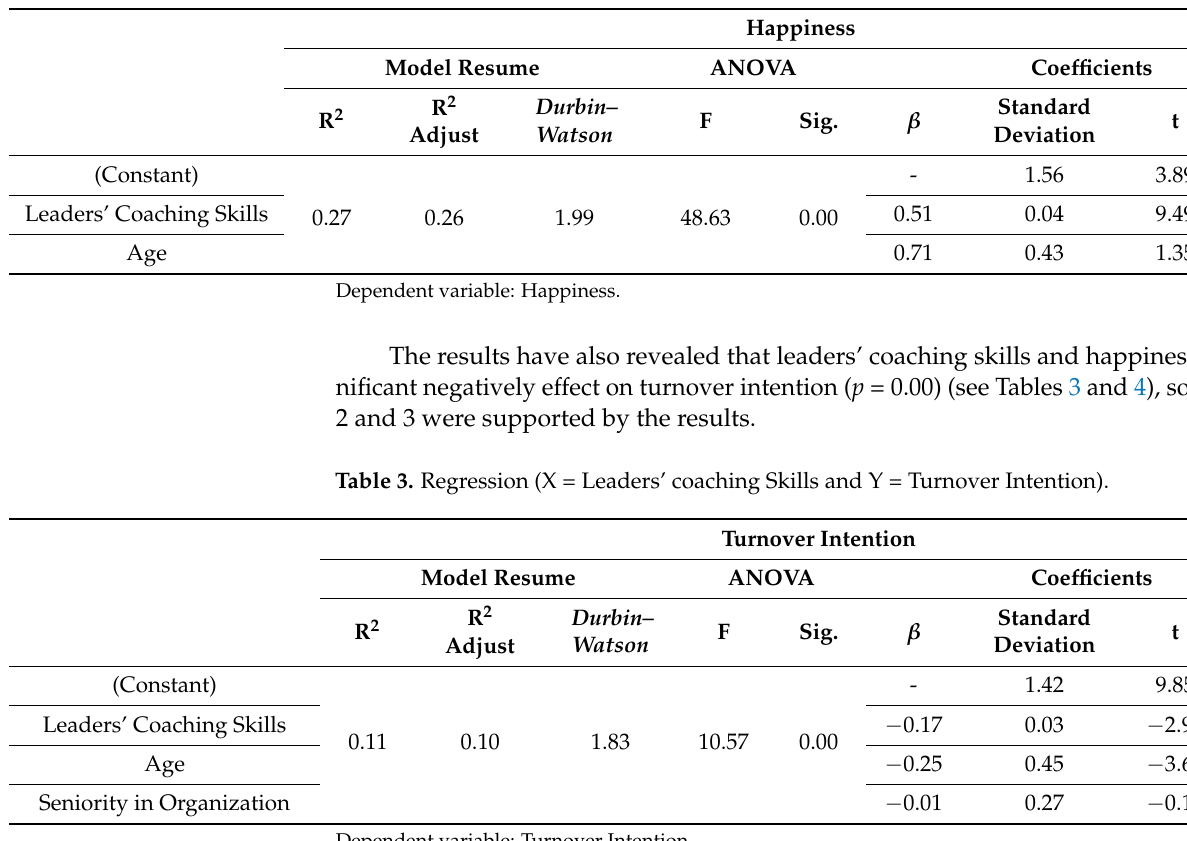
Table 2. Regression (X = Leaders’ Coaching Skills and Y = Happiness).